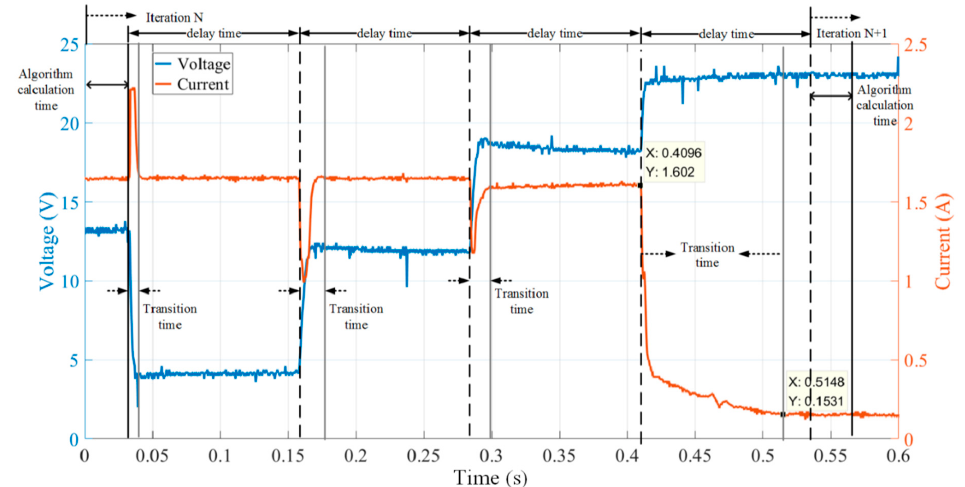
Figure 17. Operating point adjustment and delay time setting of the proposed MFA.